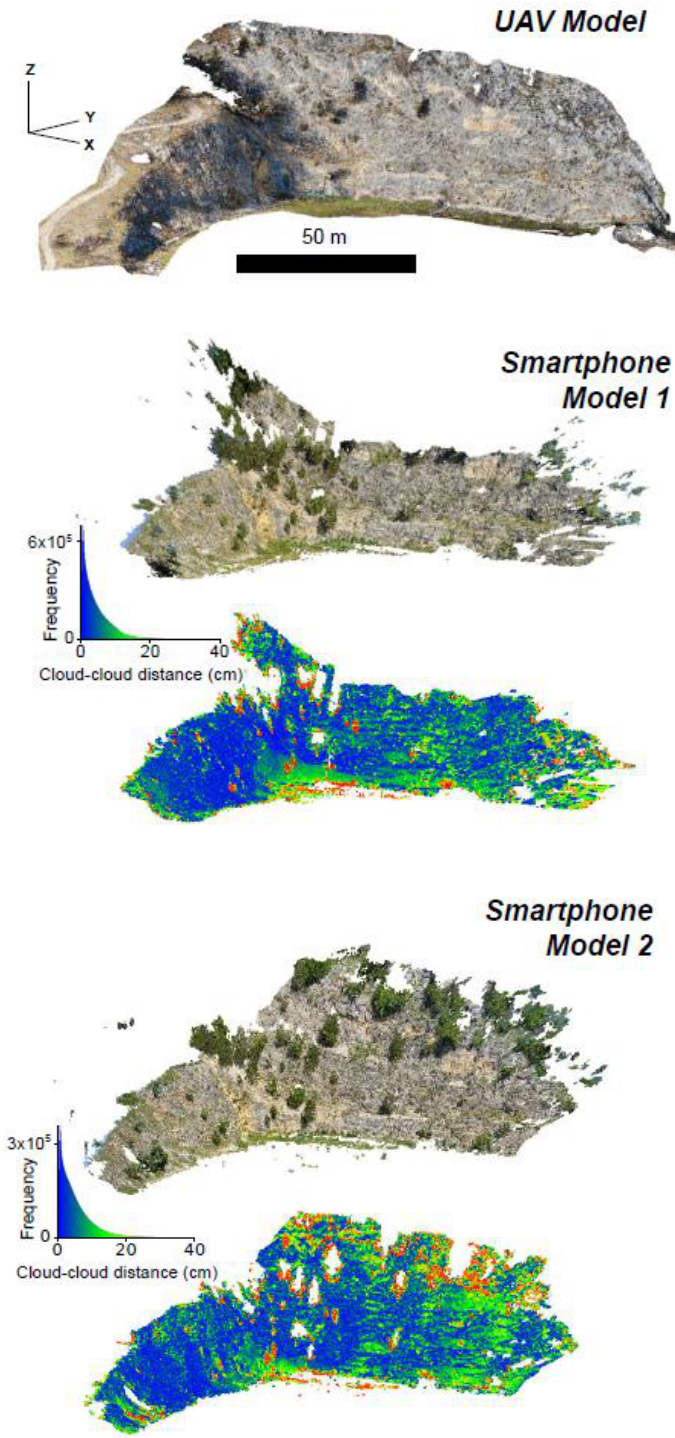
Figure 4. View from south east (SE) of the unmanned aerial vehicle (UAV) and smartphone models. For the two smartphone models, we show both the RGB model and the model colored with the cloud-to-cloud distance (along with the frequency distribution of values) between the smartphone model and the UAV